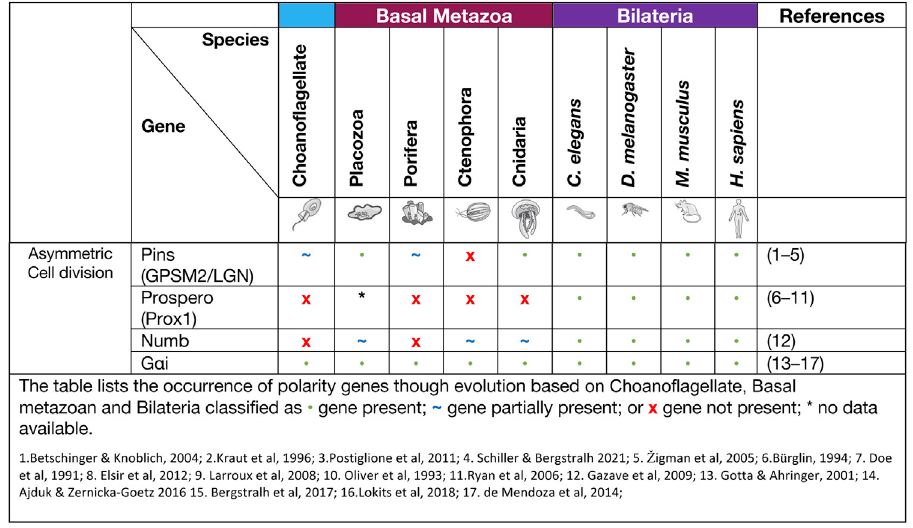
TABLE 3 Asymmetric Cell Division